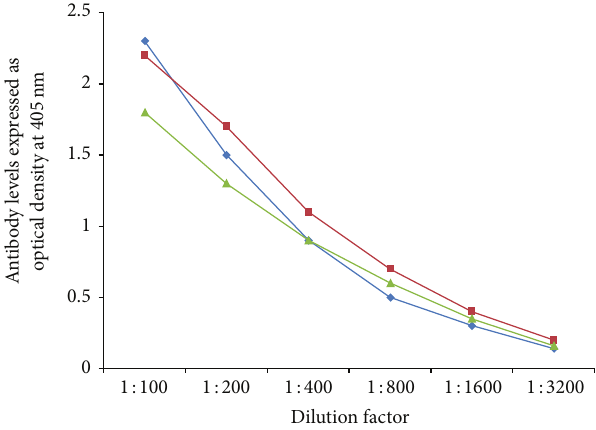
Figure 9: Serial dilution of IgG (blue diamond), IgA (green trian- gle), and IgM (red square) antibody against spinach.